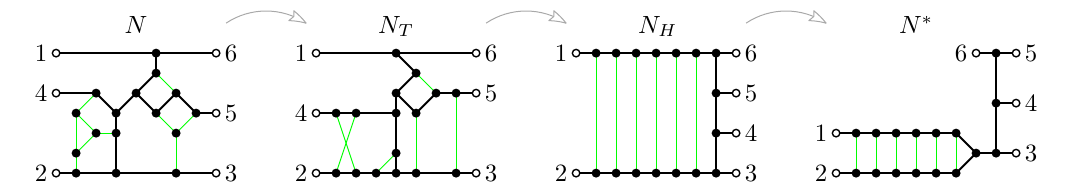
Figure 10: The process used in the proof of Theorem 5.2. We transform a network N into a tree-based network N , then into a handcuffed tree N T handcuffed caterpillar N ∗ .